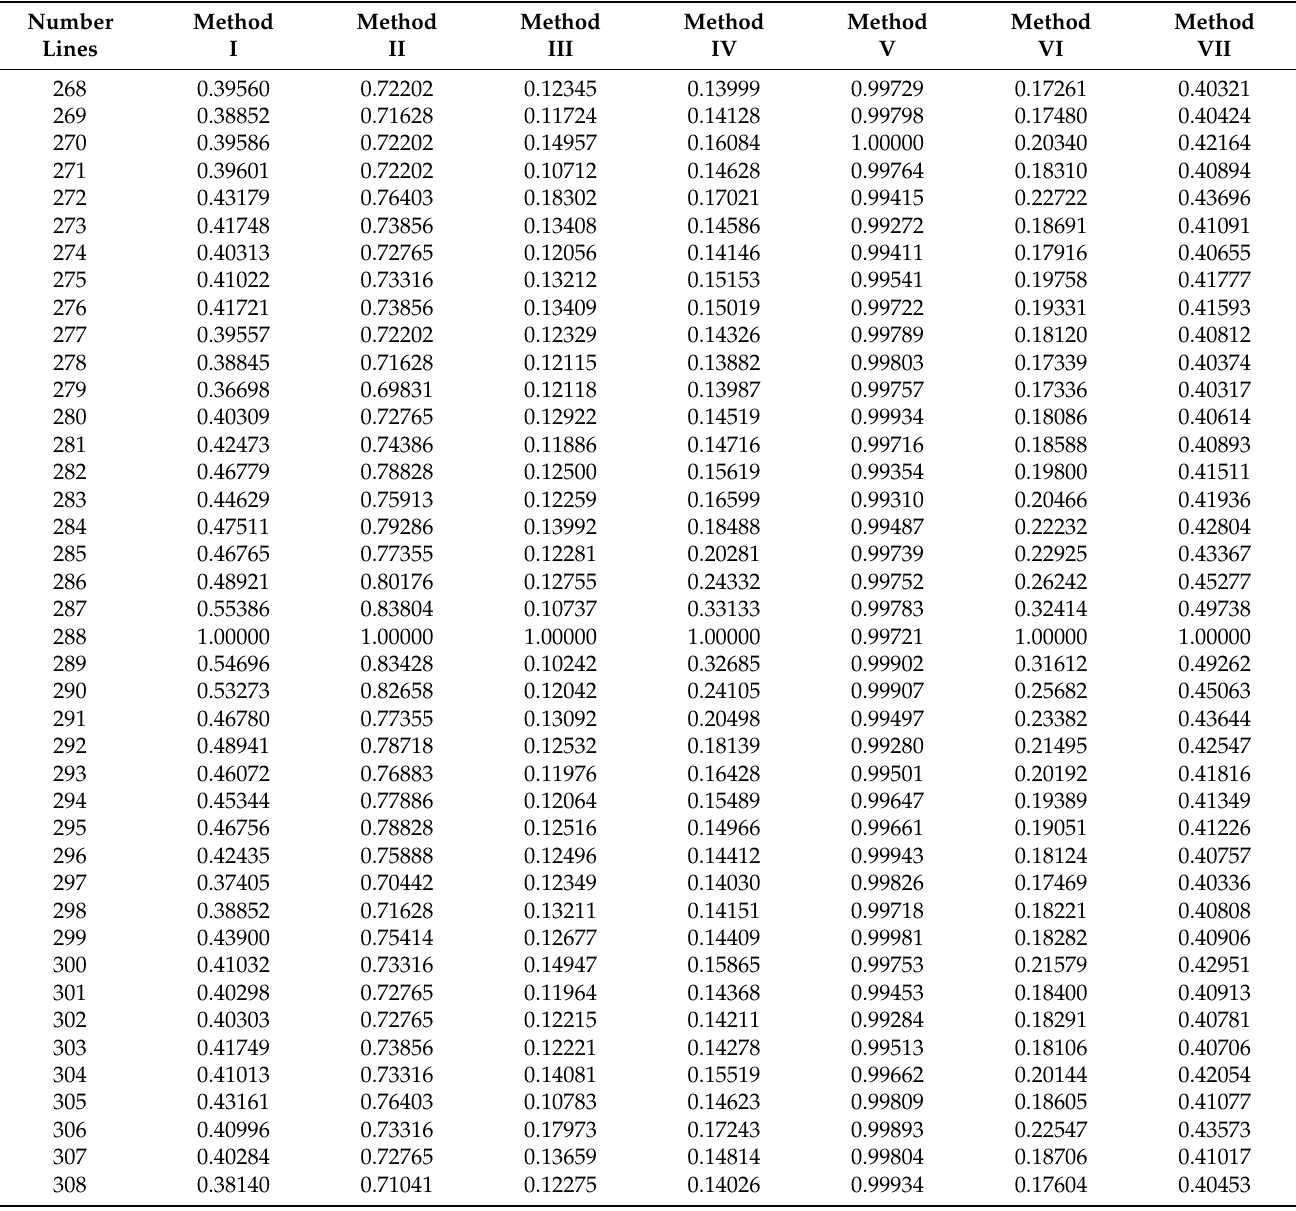
Table 4. Normalized values (in relation to the maximum value) of the variability of measures as a function of the number of image lines, supporting the determination of the correct number of lines of the image reproduced for the source image in the form of a picture from Figure